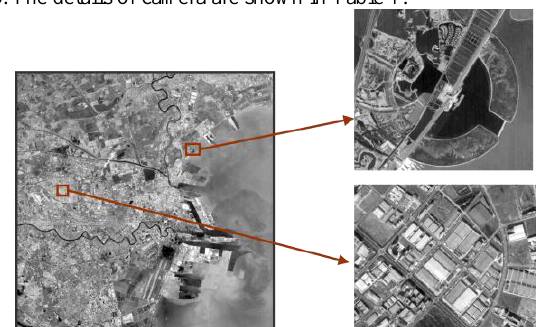
Figure 5. Tianjin image taking from high resolution camera